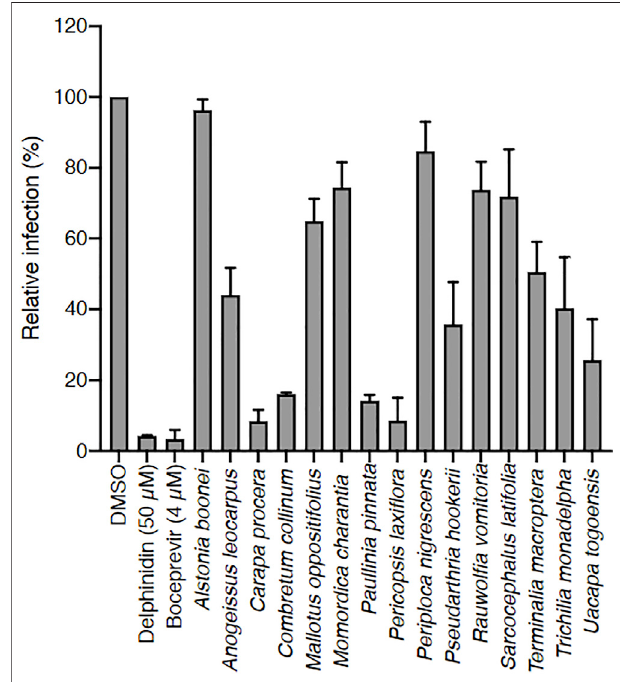
FIGURE 1 | Screening of 15 Ivorian medicinal plant crude extracts for their anti-HCV activity. Each plant was extracted with methanol, and dried extracts were dissolved in DMSO (used here as negative control). Huh-7 cells were inoculated with HCV in the presence of crude extracts at 25 μ g/ml, or delphinidin at 50 μ M, or boceprevir at 4 µM. Infected cells were quanti fi ed 30 h post infection by immuno fl uorescence detection of viral E1 protein. Data are presented relative to untreated control. Data are means ± SEM of 3 experiments performed in